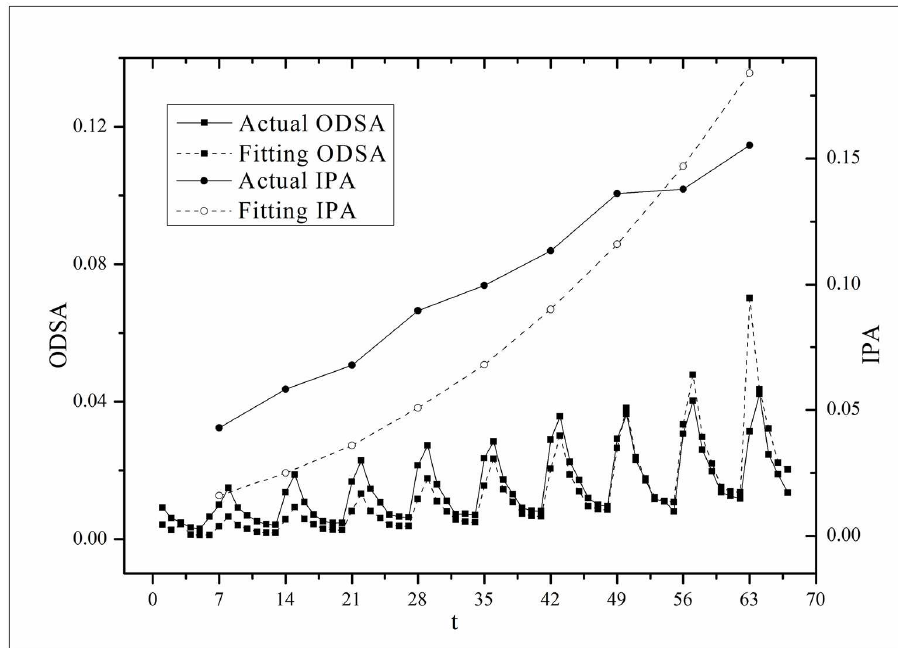
Fig 4. Two-step fitting results for the Heirs dataset.